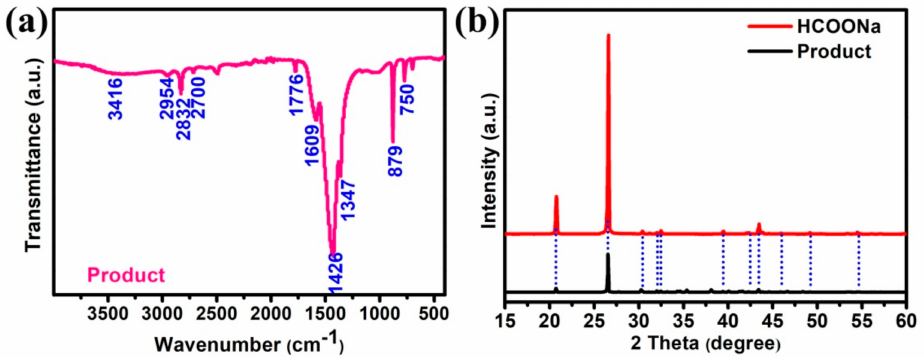
Figure 6. ( a ) FTIR spectra and ( b ) XRD pattern of the reaction products involved in catalytic HCHO oxidation over Ti 3 AlC 2 /Pd-3% catalyst. NaOH: 1 M, HCHO: 0.6 M, catalyst: 15 mg, reaction temperature: 25 ◦